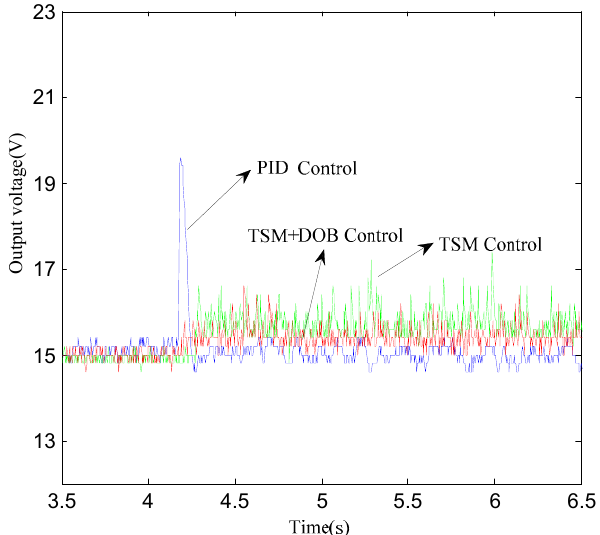
Figure 22. Experimental step-input-voltage comparisons of the output voltage under PID, TSM, and TSM + DOB control modes.